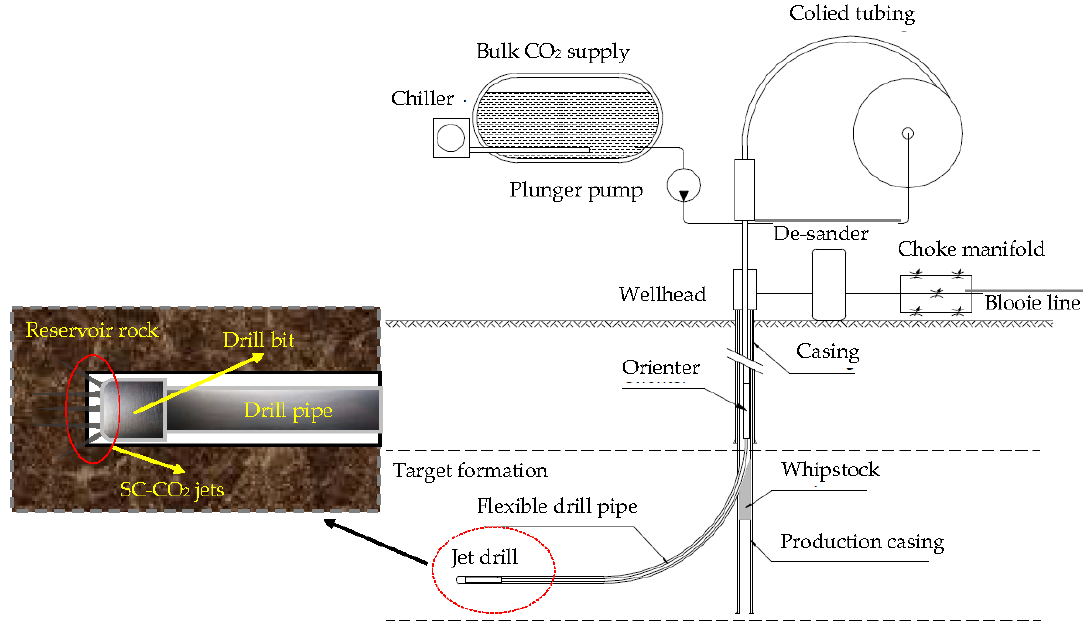
Figure 1. Schematic of coiled-tubing drilling technology using a SC-CO 2 jet [20].